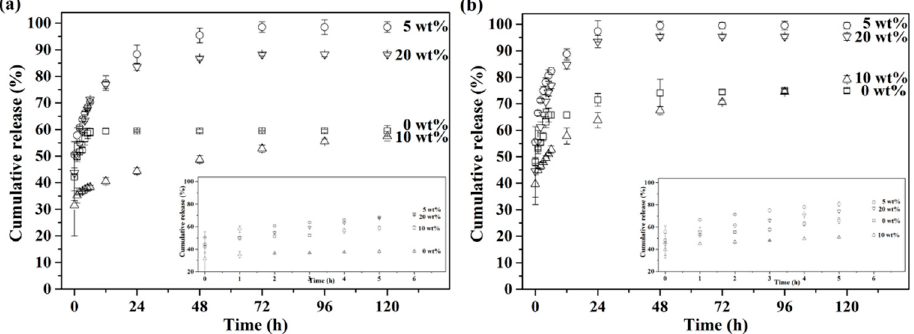
Figure 7. Cumulative tetracycline release profiles of gelatin-capsulated 0, 5, 10 and 20 wt.% PMMA-treated BG microspheres in ( a ) pH 7.4 and ( b ) pH 5.0 PBS solution at 37 °C.